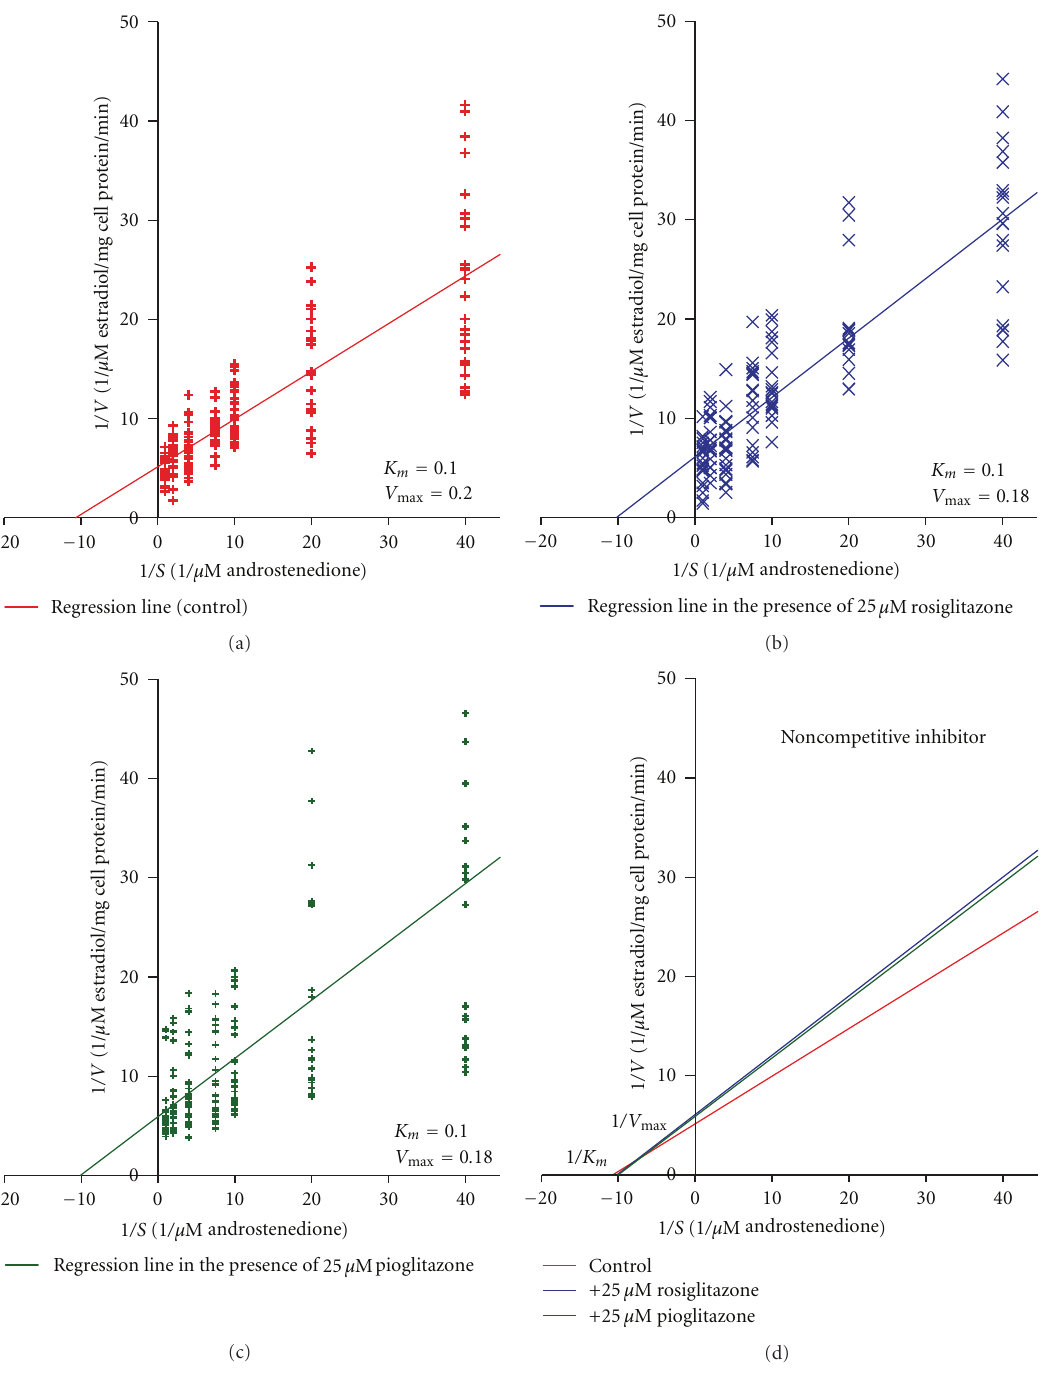
Figure 2: E ff ects of TZDs on aromatase enzyme kinetics when androstenedione was used as substrate. (a) The Lineweaver-Burk plot (recip- rocal velocities of aromatase activity against reciprocal androstenedione concentration) in the absence of rosiglitazone or pioglitazone. (b) The Lineweaver-Burk plot in the presence of rosiglitazone. (c) The Lineweaver-Burk plot in the presence of pioglitazone. (d) Comparison of the Lineweaver-Burk plots in the presence or absence of rosiglitazone or pioglitazone. V = velocity; S = substrate. the presence of various concentrations of substrates, allowed us to obtain more accurate Michaelis-Menten constants K m and V max